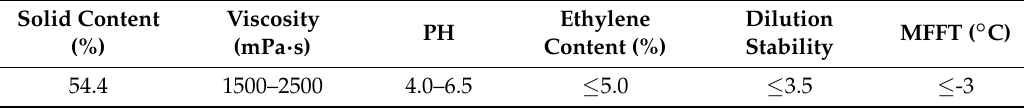
Table 4. Performance indexes of VAE.